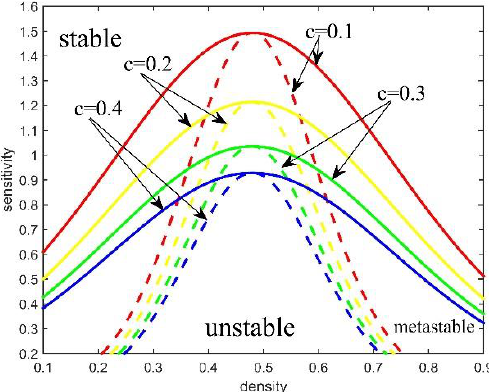
Figure 2. Phase diagrams in the density-sensitivity space for different c .